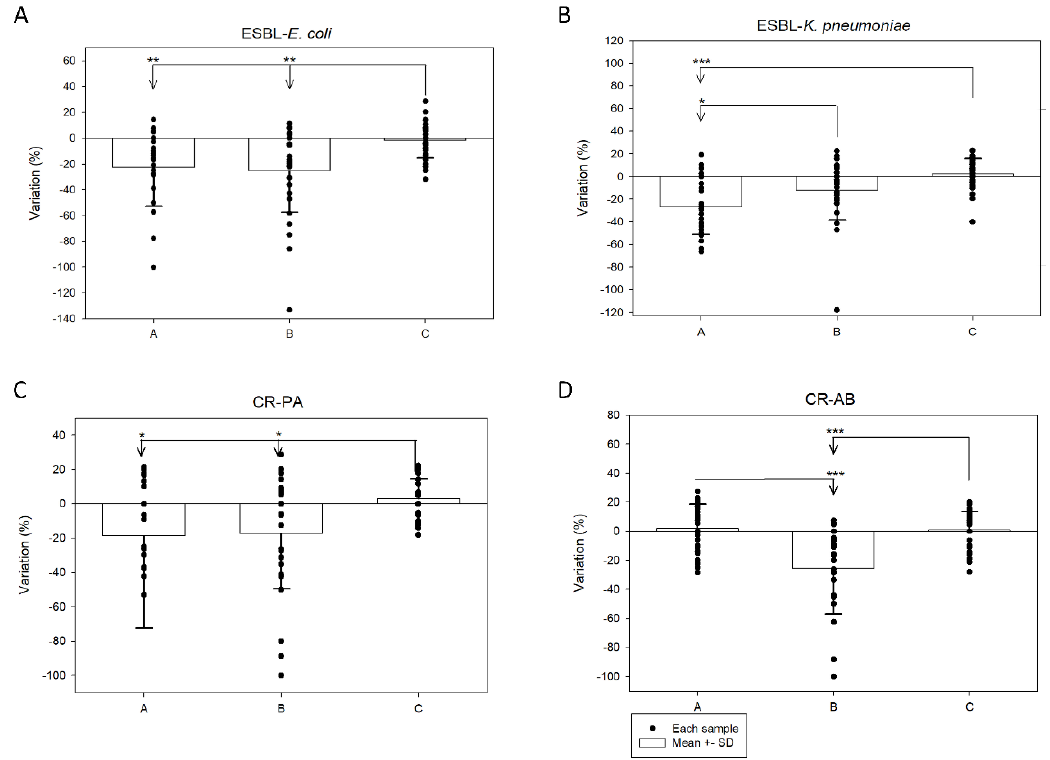
Figure 1. MIC variation in different cefoperazone/sulbactam products against extended-spectrum β-lactamase (ESBL)- E. coli ( A ), ESBL- K. pneumoniae ( B ), carbapenem-resistant P. aeruginosa ( C ), and carbapenem-resistant A. baumannii ( D ) (* p value < 0.05, ** p value < 0.001, *** p value < 0.0001).